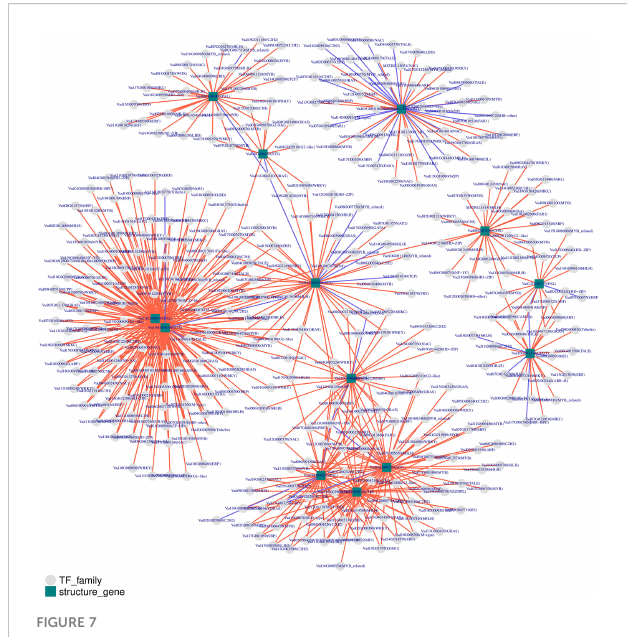
FIGURE 7 Co-expression analysis of key enzymes located in phenolic biosynthesis and transcription factors (TFs) in berries from eight grape varieties. Key enzymes are shown in rectangles and TFs in circles. CHS, chalcone synthase; COMT, caffeic acid 3- O -methyltransferase; PAL, phenylalanine ammonia-lyase; STS, Stilbene synthase; UFGT, UDP- glucose: fl avonoid 3- O -glucosyltransferase. Positive and negative correlations are provided by red arrows and purple lines,